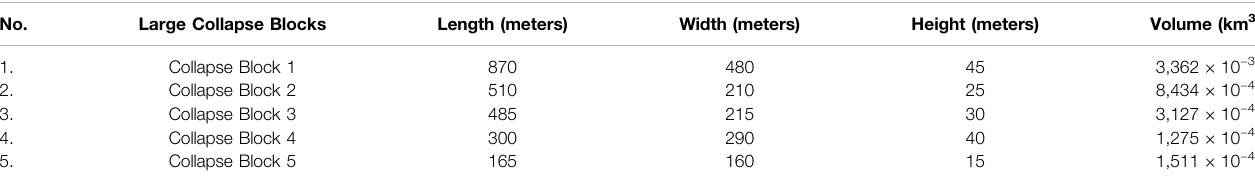
TABLE 1 | The large collapse blocks ’ dimension as a result of December, 22nd 2020 Anak Krakatau